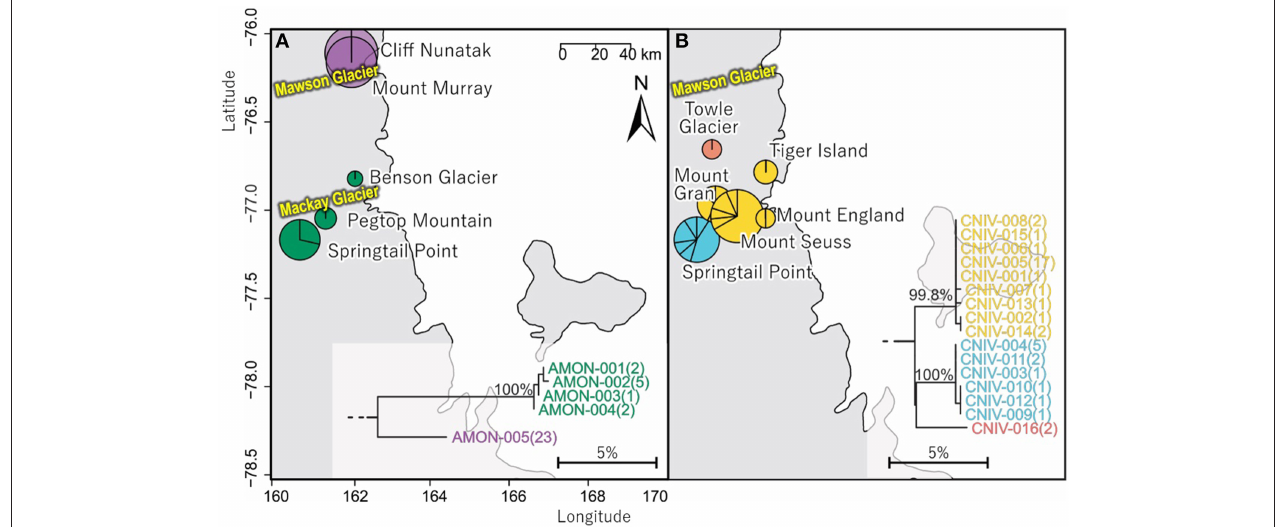
FIGURE 6 | Geographical distribution within the vicinity and to the north of Mackay Glacier in southern Victoria Land of (A) the two distinct (10.1% mean divergence) lineages of Antarcticinella monoculata (AMON; n = 33; 530 bp), and (B) the three distinct (3.3–4.3% mean divergence) lineages of Cryptopygus nivicolus (CNIV; n = 40; 586 bp), highlighting differing population genetic structure for the two springtail species. Pie charts are proportionate to the number of sequences, centered at collection site